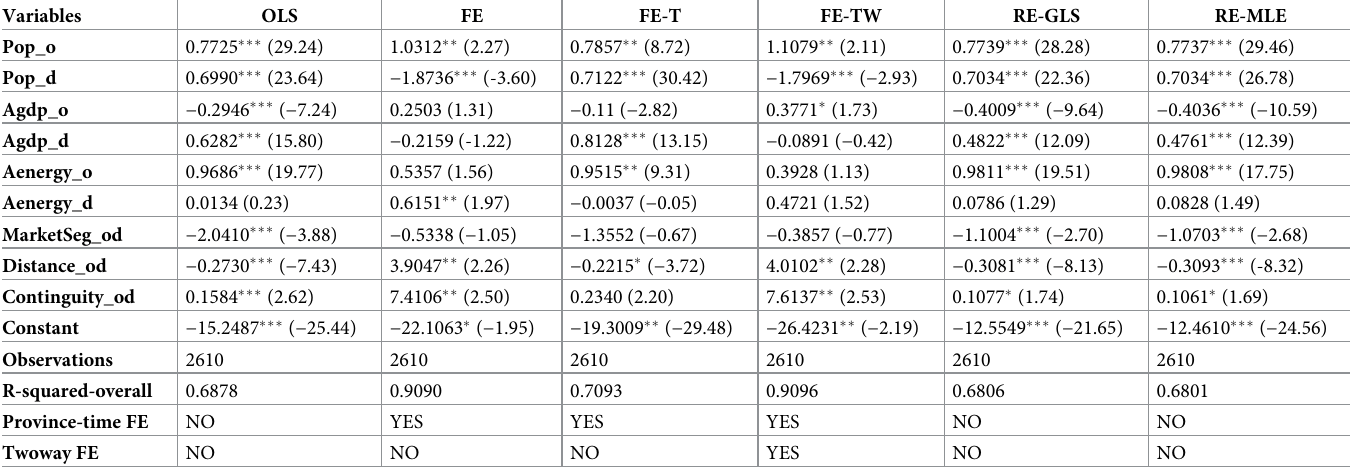
Table 1. The gravity estimated results using China’s interprovincial embodied CO 2 flows as dependent.